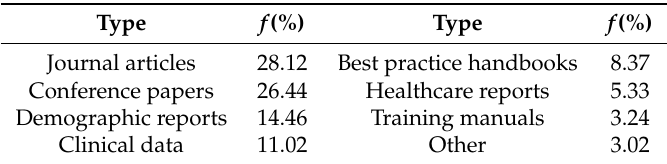
Table 12. Document types (frequency f as a